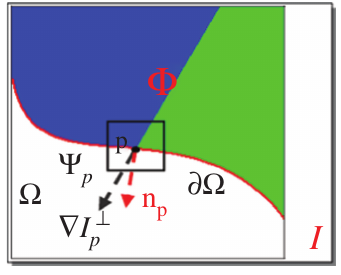
Figure 1. Notation